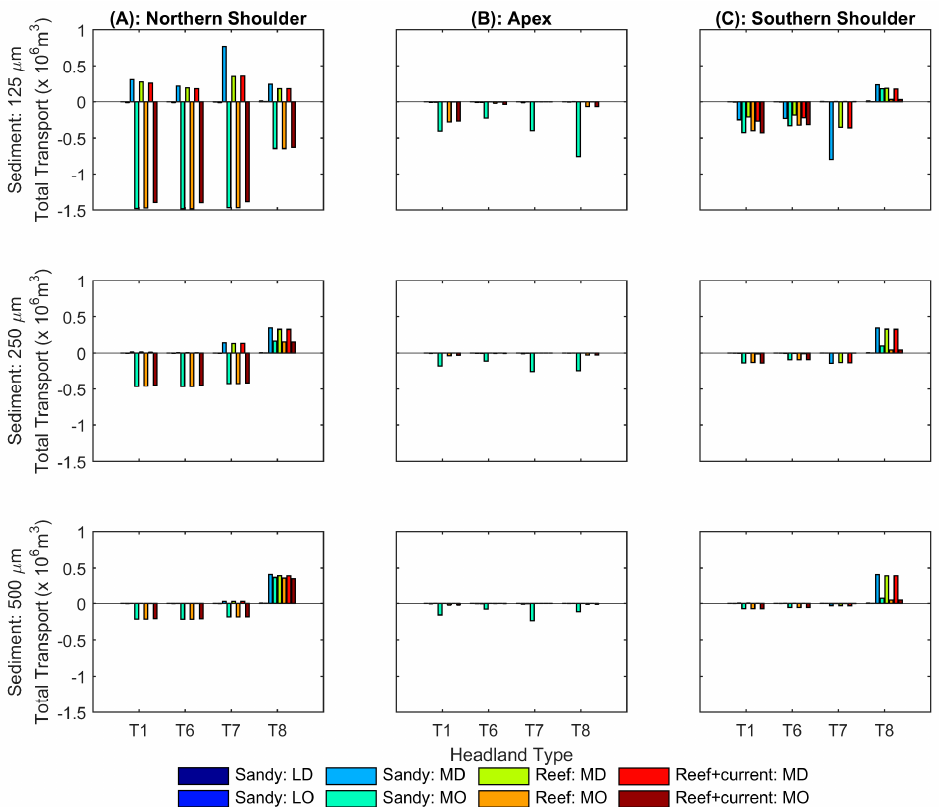
Figure 6. Cumulative total transport of the three grain sizes through a 2.5-km wide cross-shore transect on the northern and southern headland shoulders and across the headland apex. Results from the baseline simulation were excluded, as sediment transport volumes were negligible. Positive values indicate northward (upstream) transport; negative values indicate southward (downstream) transport.